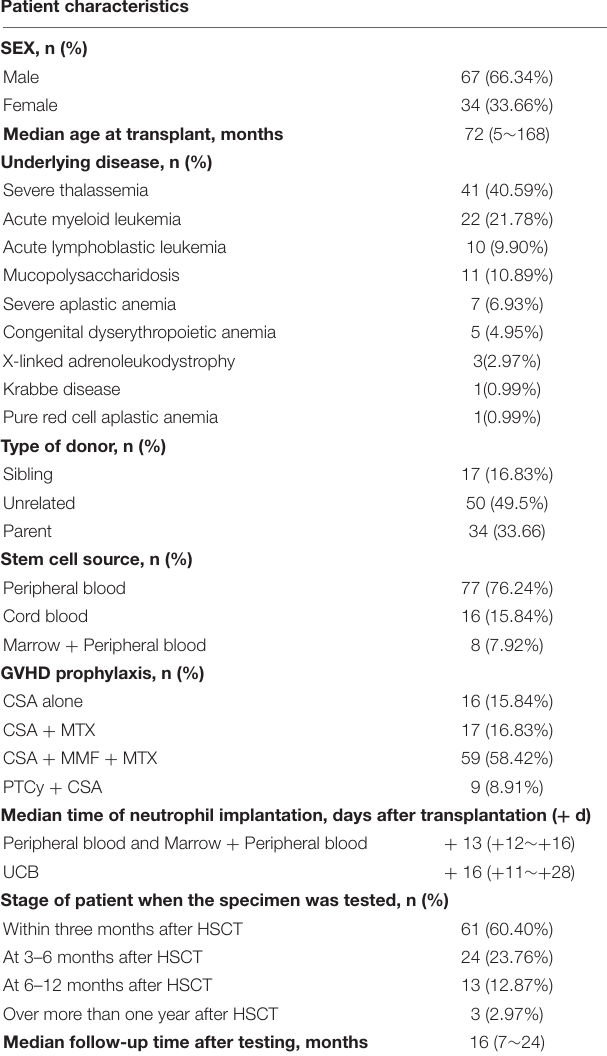
TABLE 1 | Patient and transplantation characteristics ( N =